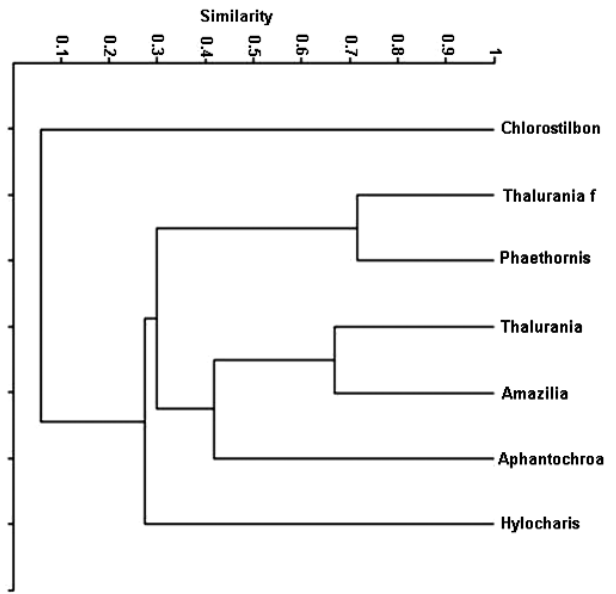
Fig. 4 – Cluster analysis representing the similarity (Jaccard’s index) among the hummingbird species ( Chlorostilbon lucidus , male and female of Thalurania furcata , Phaethornis pretrei , Amazilia versicolor , Aphantochroa cirrochloris and Hylocharis chrysura ) concerning their use of floral resources in two habitats of Serra da